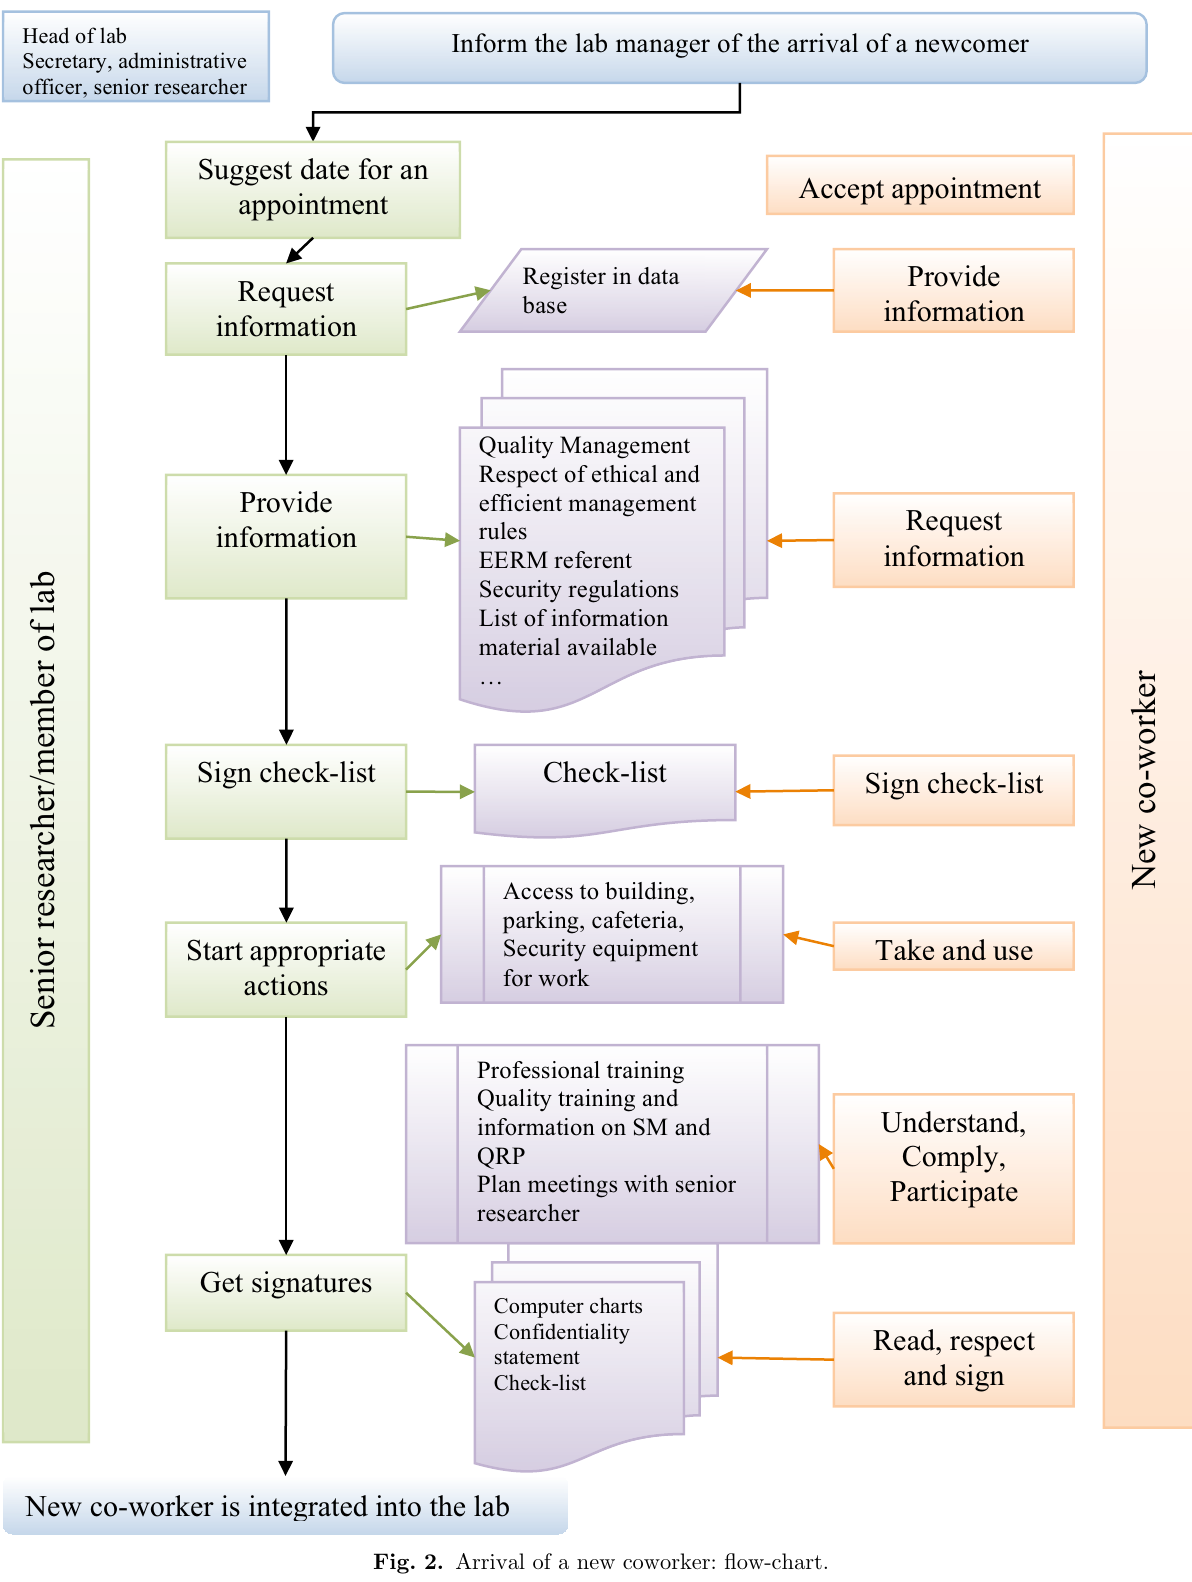
Fig. 2. Arrival of a new coworker: fl